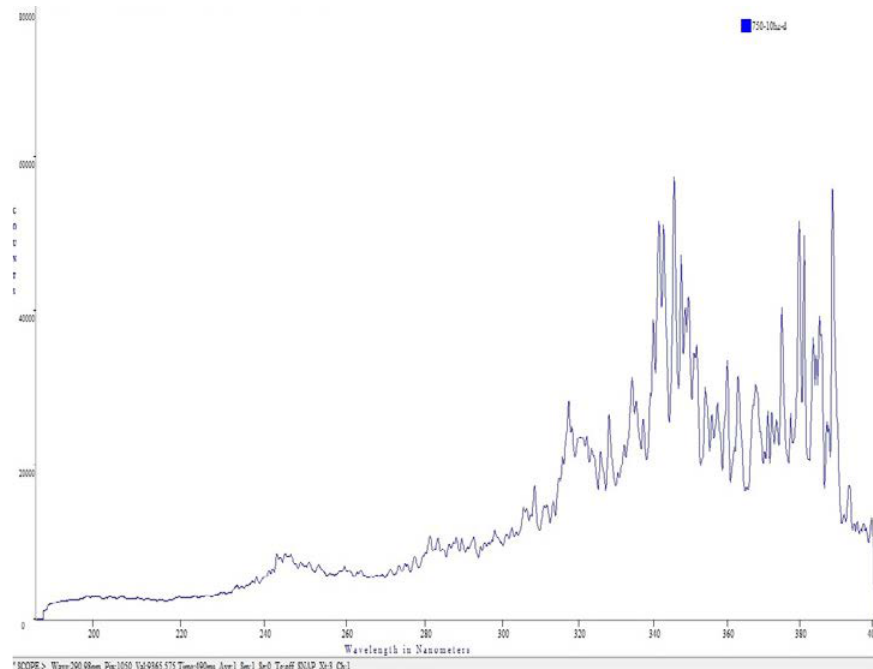
Fig.11: Emission spectra of laser energy 750 mJ with 10Hz repetition rate .